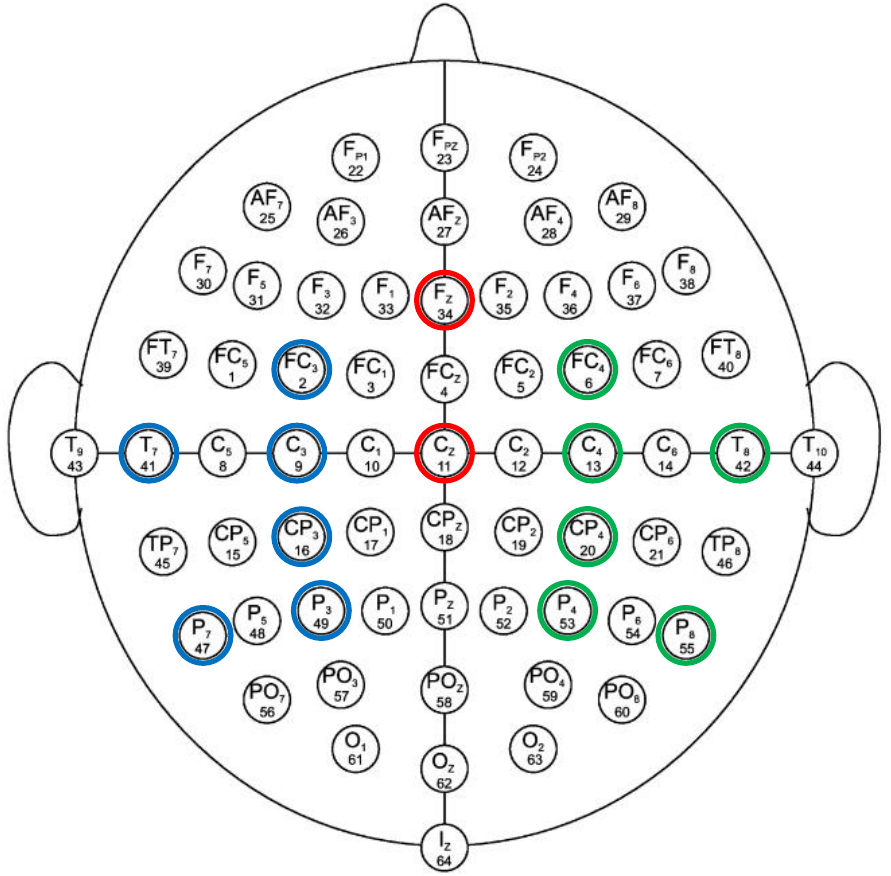
Figure 2. Standard 10–10 EEG electrode configuration. Selected electrodes from left, right and central region are encircled with blue, green and red color,